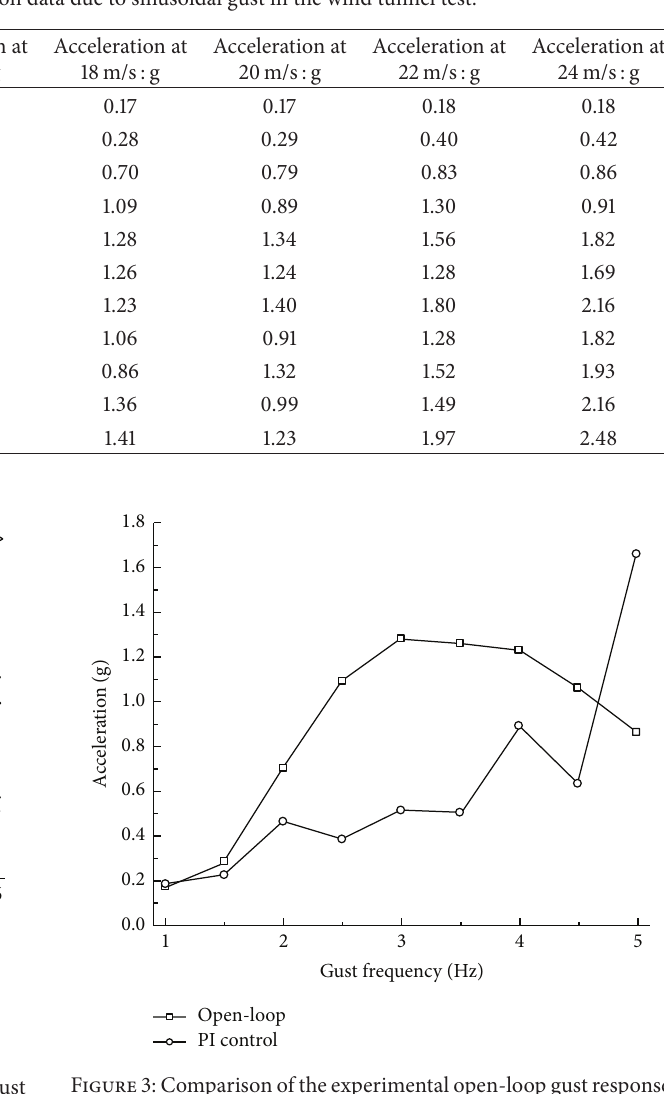
Figure 3: Comparison of the experimental open-loop gust response and the closed-loop one by PI